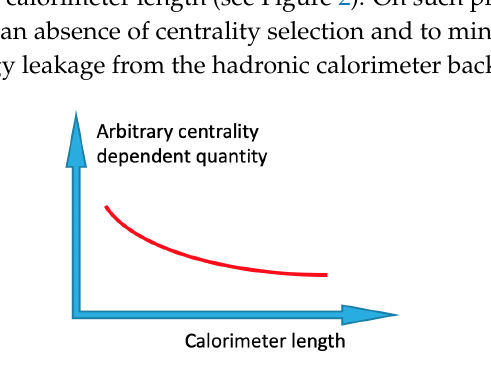
Figure 2. A sketch of how a collision volume depended quantity behaves with the increase of a centrality calorimeter